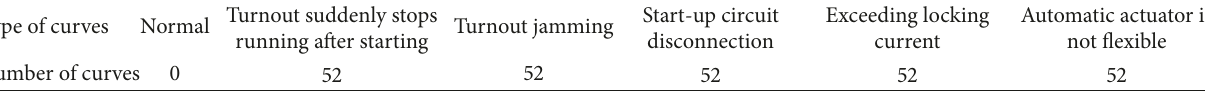
Table 2: The number of different kinds of curves.